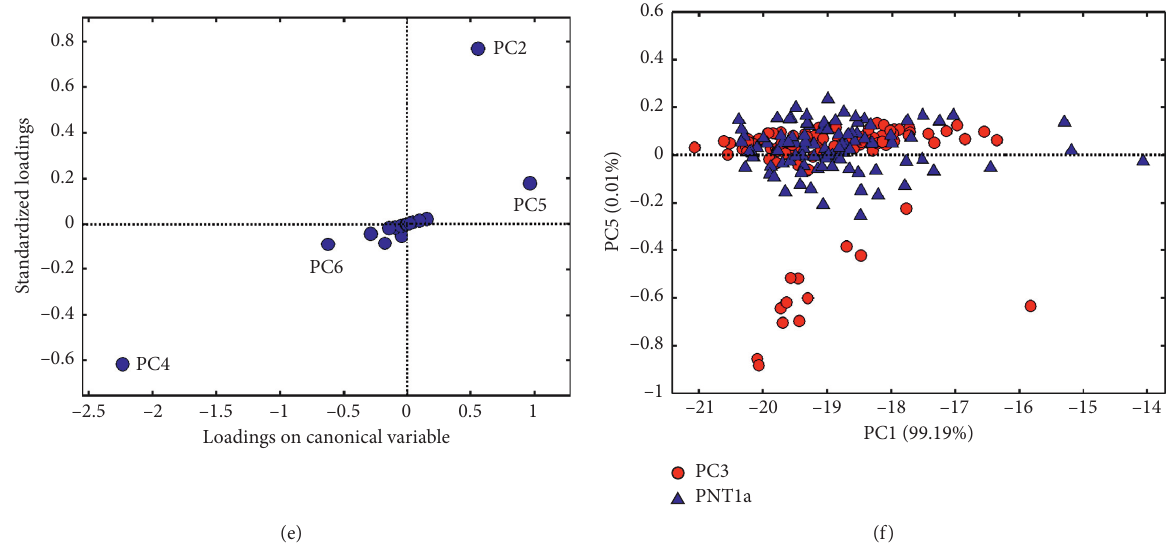
Figure 5: Canonical variable distribution of principal components for (a) stage 1, (c) stage 2, and (e) stage 3 measurements and the score plots of the first principal component (PC 1) against the intermediate- and high-order PCs for (b) stage 1, (d) stage 2, and (f) stage 3 measurements. The clustered principal components (centered on origin) had poor discrimination of scores and were therefore discarded from the